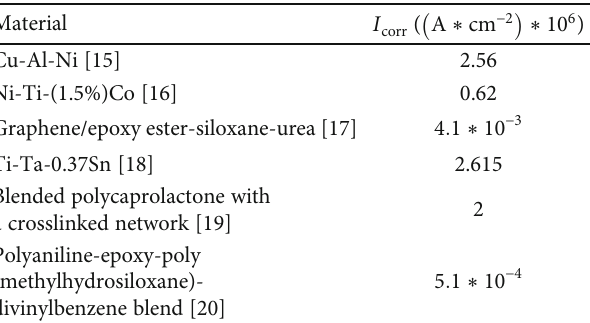
Table 2: Current densities of various alloys and polymers.